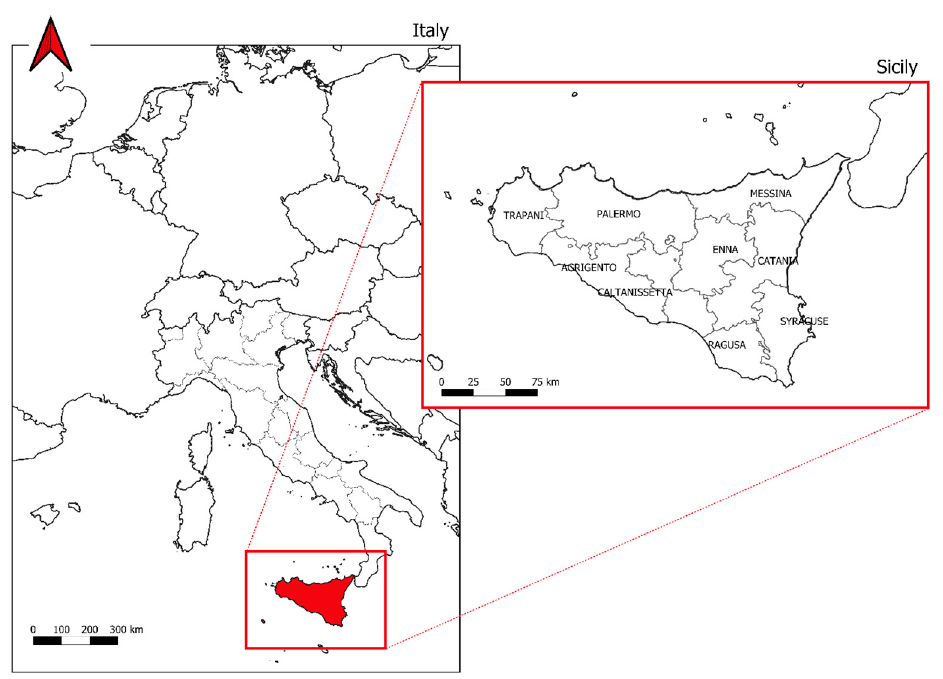
Figure 1. Study area geographic position.